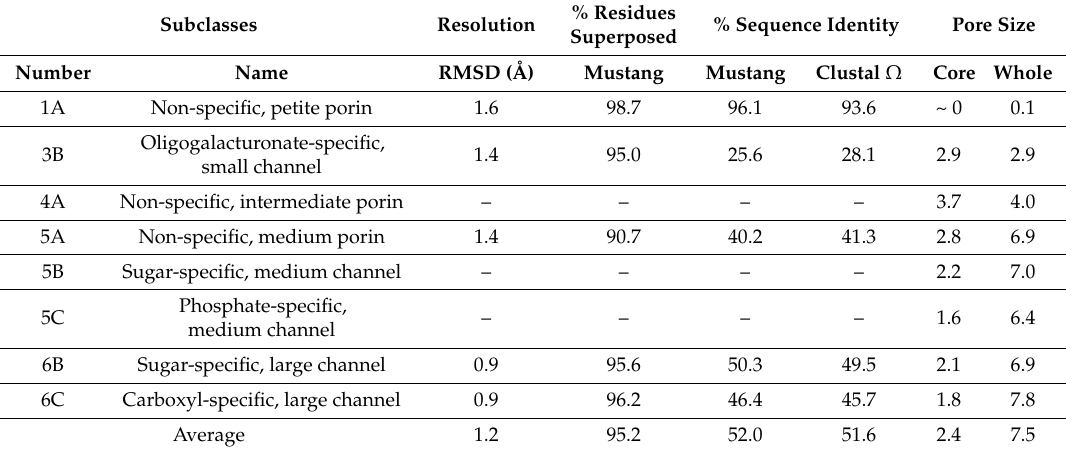
Table 4. Structure alignment statistics of non-specific porins and specific diffusion channels. Core structures are analyzed after the loops were removed (so only the barrel was used). The percentages of aligned residues are averages for each pair-wise alignment possible in the subclass. Empty cells represent classes with only one structure. Minimum pore radii are determined using HOLE [37] for the whole monomeric protein and its β -barrel core, respectively.